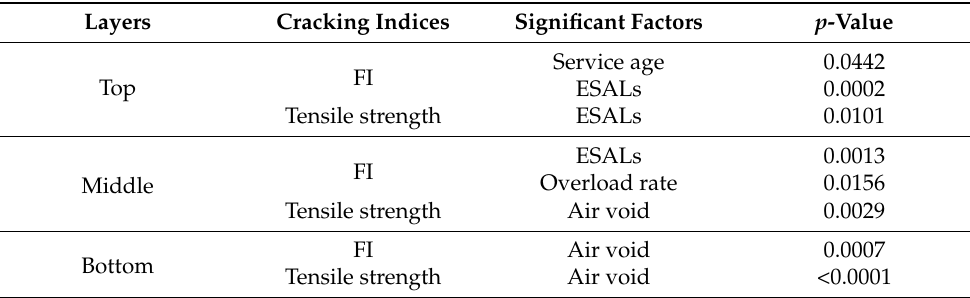
Table 4. Summary of factors affecting the cracking resistance for three asphalt layers.